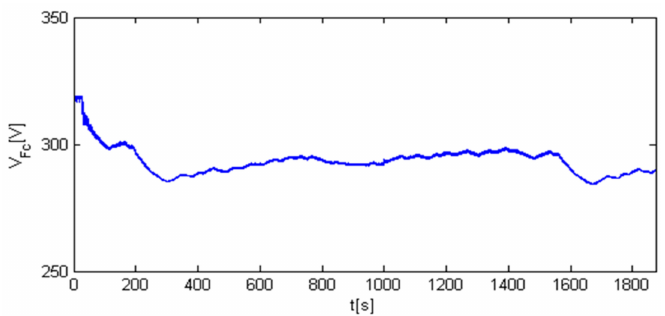
Figure 23. Fuel cell stack terminal